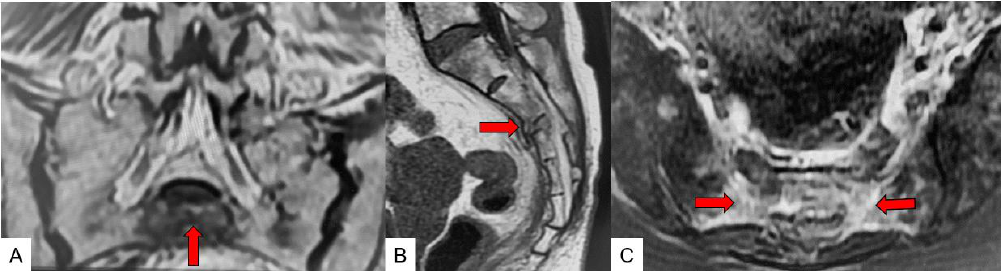
Figure 2. Sacral insufficiency fracture. ( A ): Coronal T2-weighted MR image, ( B ): Sagittal T1-weighted MR image, ( C ): Axial T2-weighted MR image, red arrows indicate fracture line.